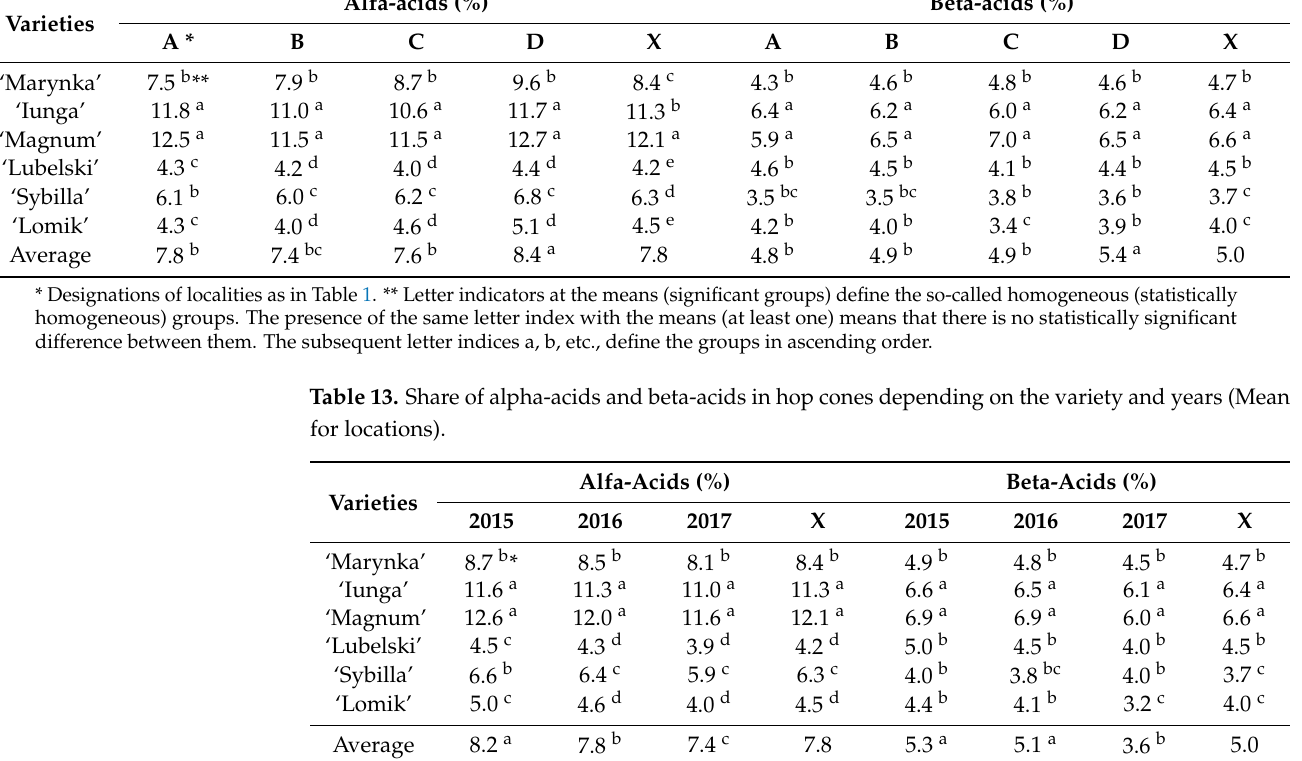
Table 12. Share of alpha acids and beta acids in hop cones depending on the variety and locality (Mean 2015–2017). Varieties